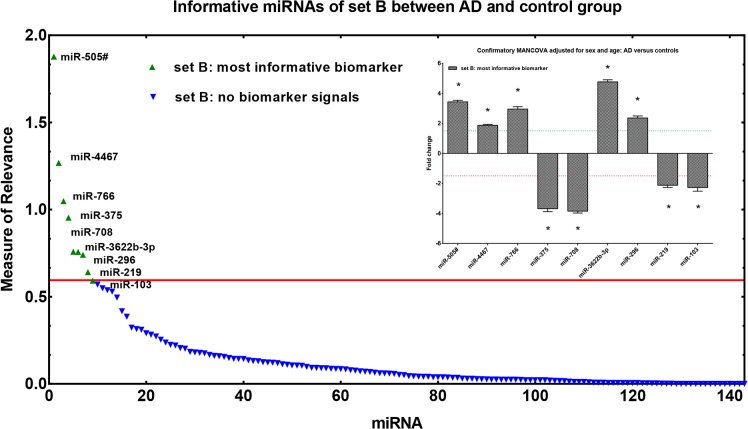
Measure of Relevance for miRNA expression data in CSF.Application of the MoR approach to miRNAs of set B for identifying relevant expression differences between controls and AD cases. In the control group n = 28 and in the AD group n = 22 subjects were examined. MoR-values over the red line are to be declared as informative (critical MoR-value for the informative designation d = 0.57). Bar diagram of the most informative biomarker signals of set B. Stars (*) over the bars point to significant p-values in MANCOVA (MANCOVA, p < α*, where α* is Bonferroni corrected α = 0.05).